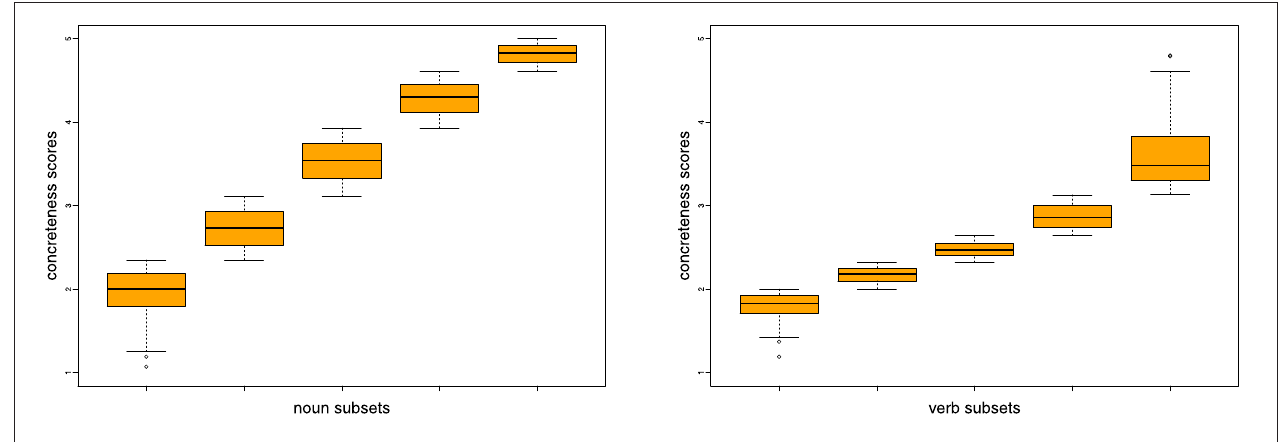
FIGURE 3 | Concreteness ranges of noun and verb subsets (each containing 20% of respective total